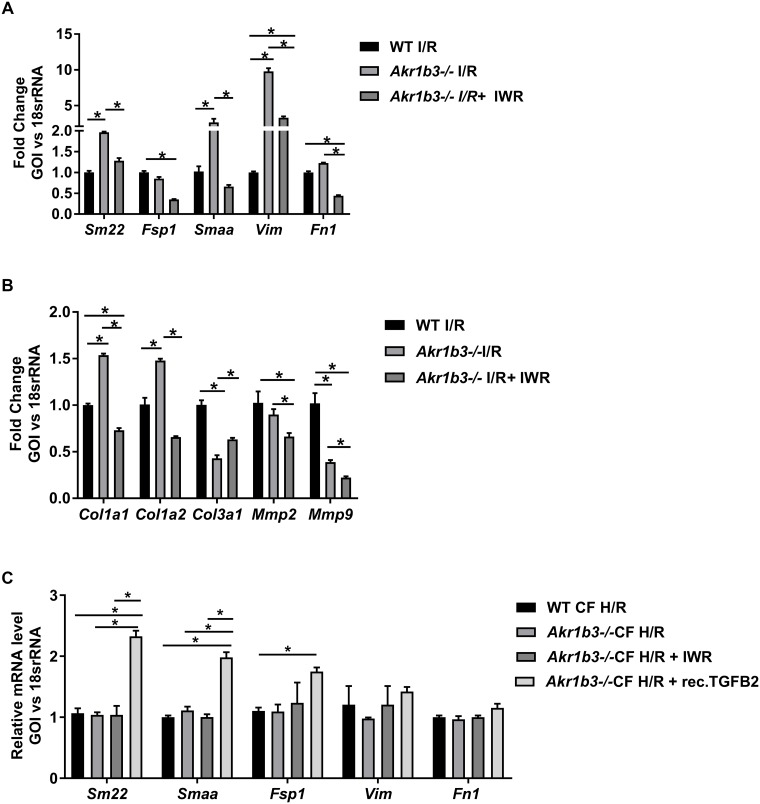
β-Catenin pathway inhibitor reverses the Akr1b3 null mediated protection and mesenchymal marker expression.Mice hearts were subjected to ex vivo I/R using Langendorff technique. (A) qRT-PCR on heart tissues for mesenchymal markers as indicated, N = 3. (B) qRT-PCR on heart tissues for collagen and matrix metalloproteinases as indicated, N = 3 mice/group. (C) qRT-PCR on primary CF for mesenchymal markers treated either with recombinant TGFB2 or IWR as indicated, N = 5/group. Error bars represent mean ± SEM. * p<0.05, unless otherwise noted.